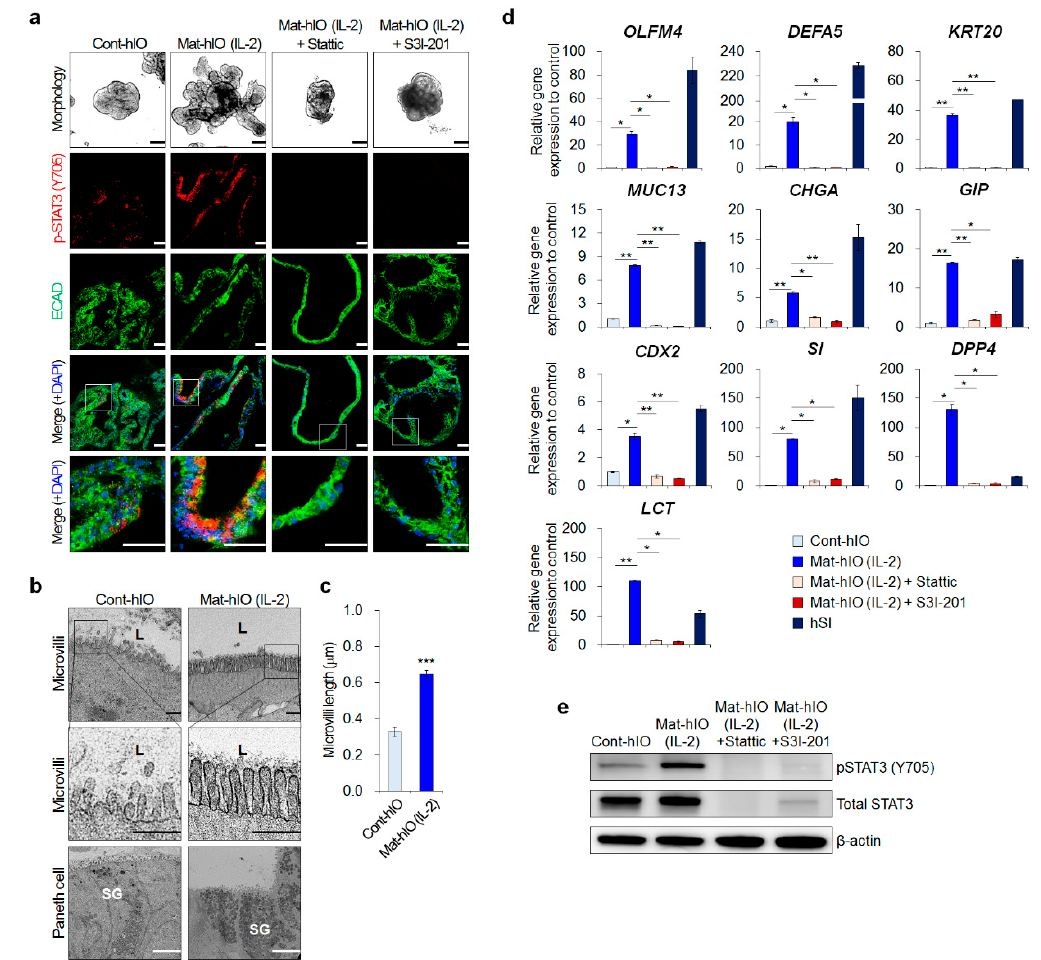
Figure 1. In vitro maturation of hPSC-derived hIOs is accompanied by the activation of STAT3 signaling. ( a ) Representative morphologies and immunofluorescence staining with p-STAT3 (Y705) and ECAD in Cont-hIOs, and IL-2 treated Mat-hIOs in the presence or absence of STAT3 inhibitors, including Stattic (1 µ M) or S3I-201 (10 µ M). Black scale bar, 200 µ m. White scale bar, 50 µ m. ( b ) Transmission electron microscopy images for epithelial characterization of control hIOs and IL-2-treated Mat-hIOs. ‘L’ indicates lumen, and ‘SG’ indicates secretory granules. Black scale bar, 500 nm. White scale bar, 5 µ m. ( c ) The length of microvilli (after three passages of maturation, n = 20 per group). ( d ) qPCR analysis of intestinal cell type-specific maturation markers in Cont-hIOs, IL-2 treated Mat-hIOs in the presence or absence of STAT3 inhibitors (Stattic, S3I-201), and hSI (hIOs passage 4, n = 3 per group). Data are presented as the mean value of replicates ± standard error of the mean (SEM). *** p < 0.001, ** p < 0.01, and * p < 0.05 according to Student’s t -test. ( e ) Western blot analysis of p-STAT3 (Y705) and STAT3 in Cont-hIOs and IL-2 treated Mat-hIOs in the presence or absence of STAT3 inhibitors.